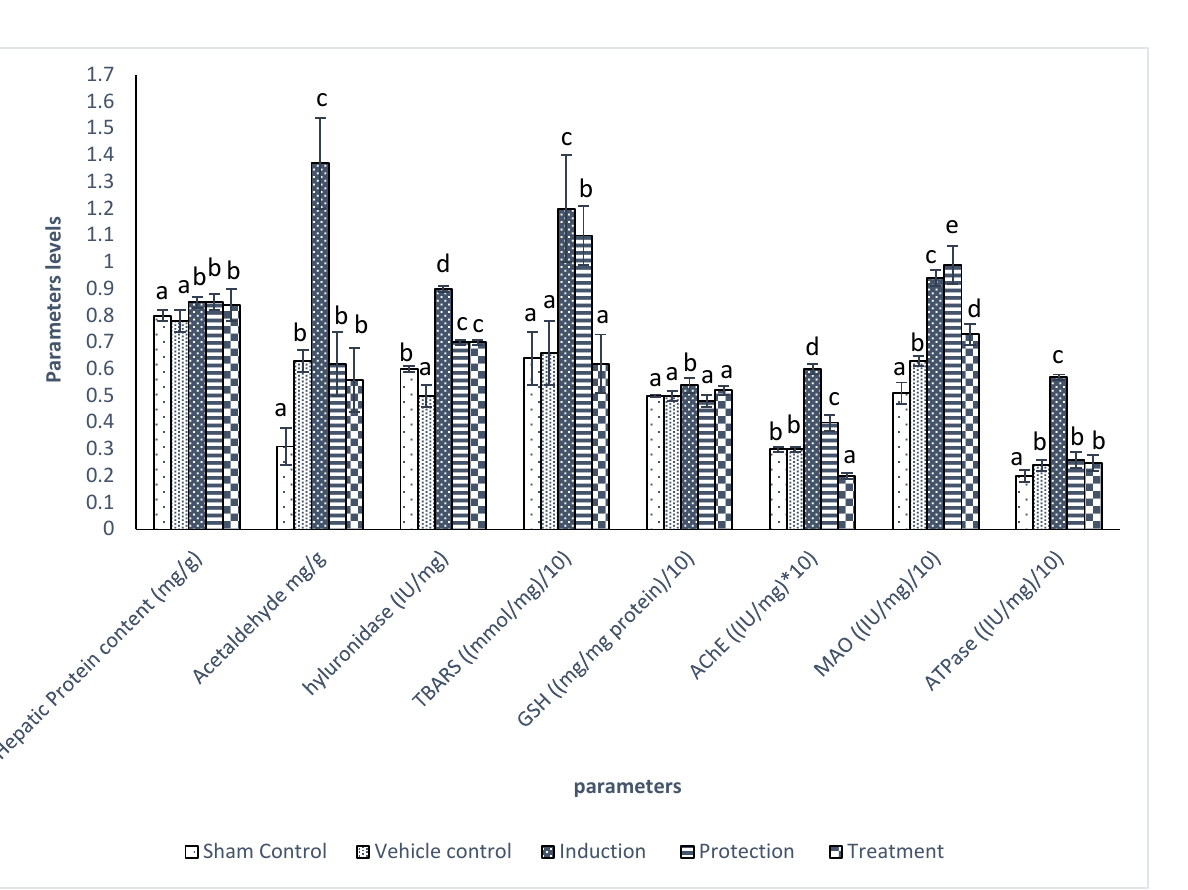
Figure 2. Effect of different treatments on hepatic protein, energy-producing markers (acetaldehyde and ATPase), oxidative stress markers (TBARS and GSH), neurotransmitter catabolizing enzymes (AChE and MAO), and fibrotic marker (hyaluronidase). Data are represented as M±SD. For each parameter, means with different letters are significantly different at p < 0.05. The mean with the letter (a) is the smallest, followed by b, c, etc. * is multiplication sign.